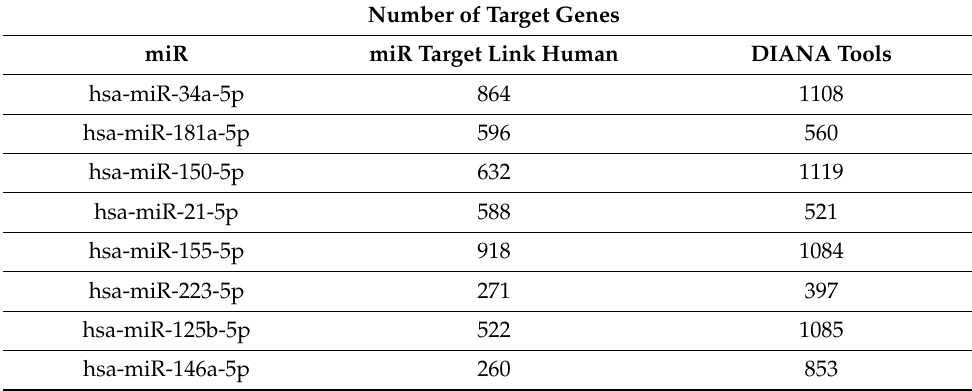
Table 3. Bioinformatics tools for in silico analysis.